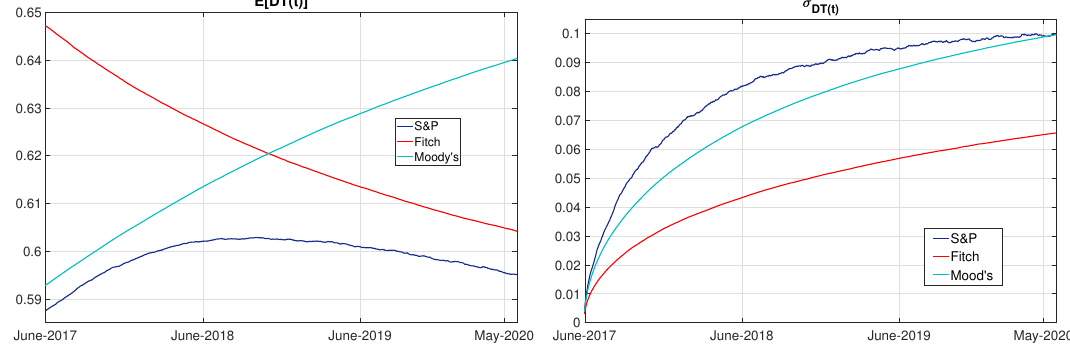
Figure 5. Expected value and standard deviation of the dynamic Theil